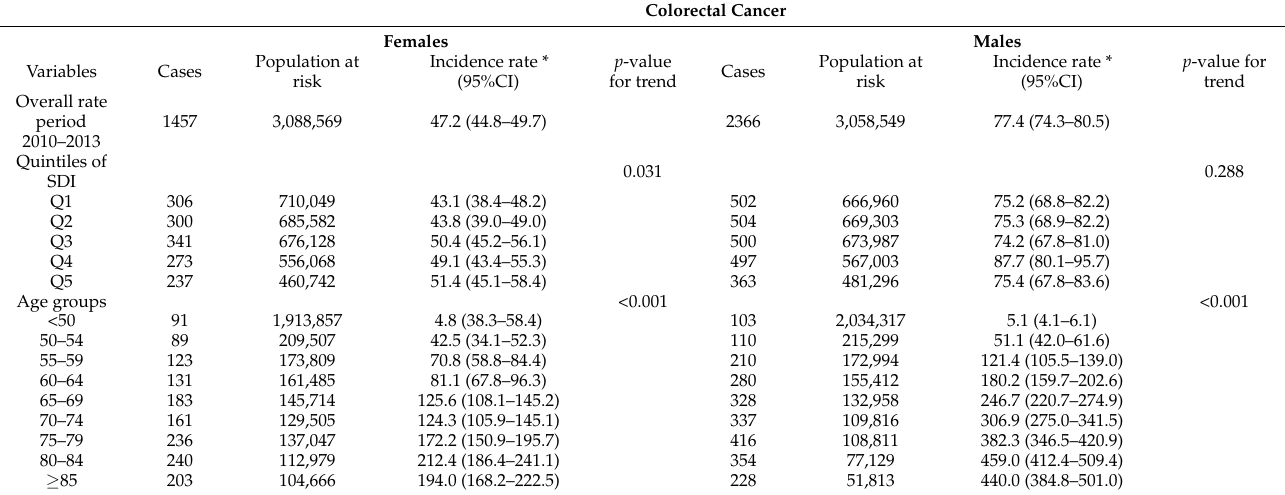
Figure 1. Quintiles of the Spanish Deprivation Index (SDI) by census tract in the nine Spanish provinces under study, 2011. Table 1 shows the total number of cancer cases, the population at risk, and the observed incidence rates per 100,000 people during the period 2010–2013 by cancer site, sex, quintiles of deprivation, and age groups. Table 1. Cancer incidence, population at risk, incidence rate per 100,000 people, and p -value for trend by sex, deprivation, and age groups in Spain for the period 2010–2013.